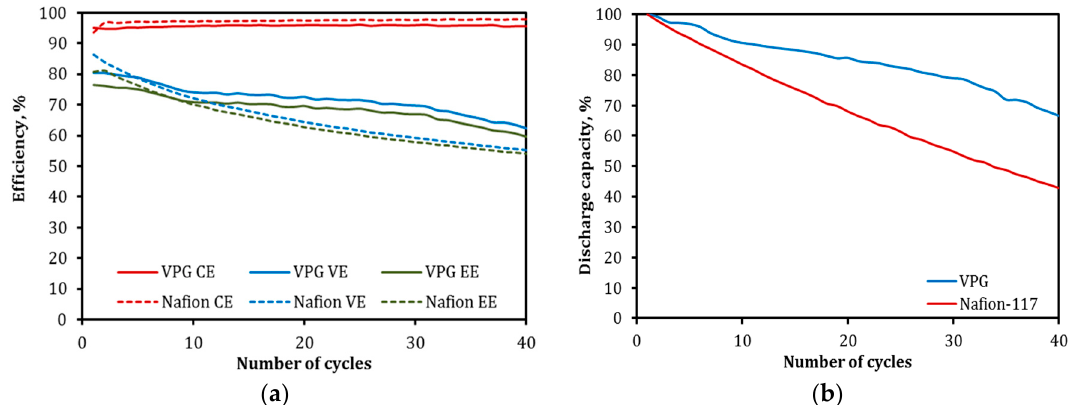
Figure 17. Comparisons of cyclic operation between the VPG-VRFB and Nafion-VRFB at 45 °C for a current density of 40 mA/cm 2 : ( a ) CE, VE, and EE as functions of cycle number and ( b ) discharge capacity as a function of cycle number.